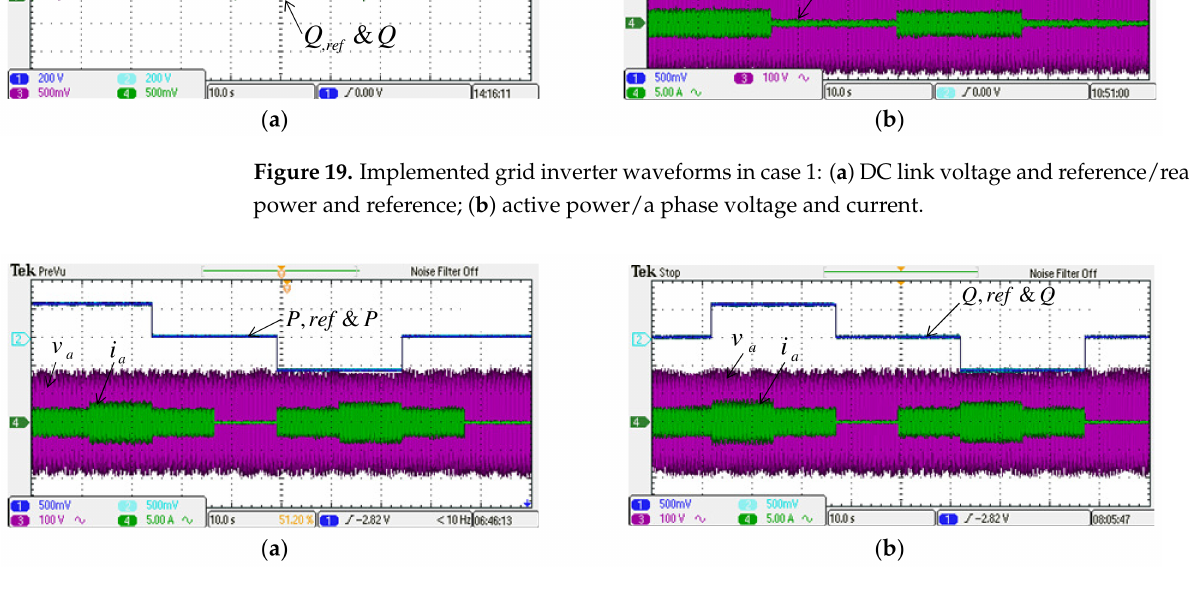
Figure 20. Implemented MG inverter waveforms in case 1 ( a ) active power and reference/reactive power and reference, ( b ) active power and reference/a phase voltage and